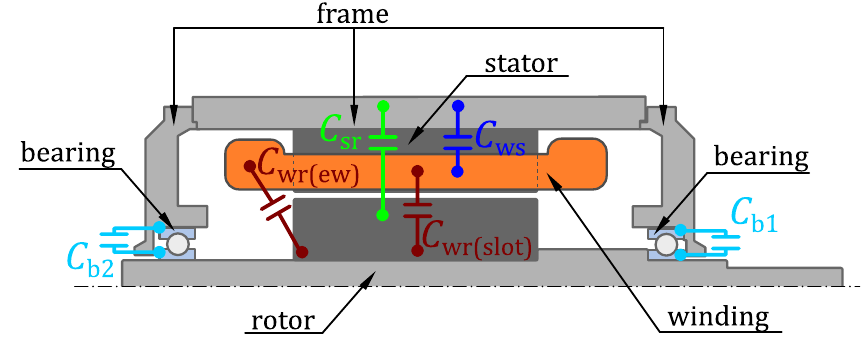
Figure 4. Distribution of parasitic capacitances in an electric machine.